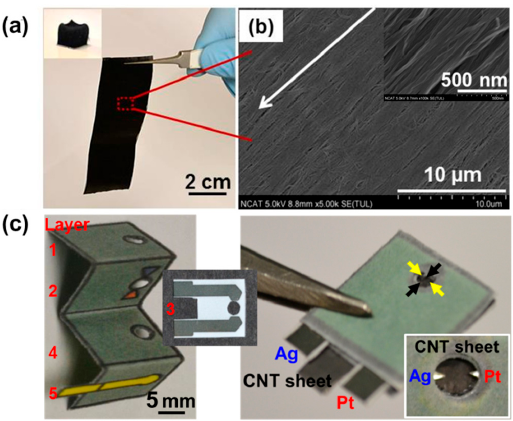
Figure 3. ( a ) Free standing HA-CNT sheet paper (insert: optical image of CNT array just before the CNT sheet is pulled out). ( b ) SEM image of the HA-CNT sheet paper (insert: enlarged SEM